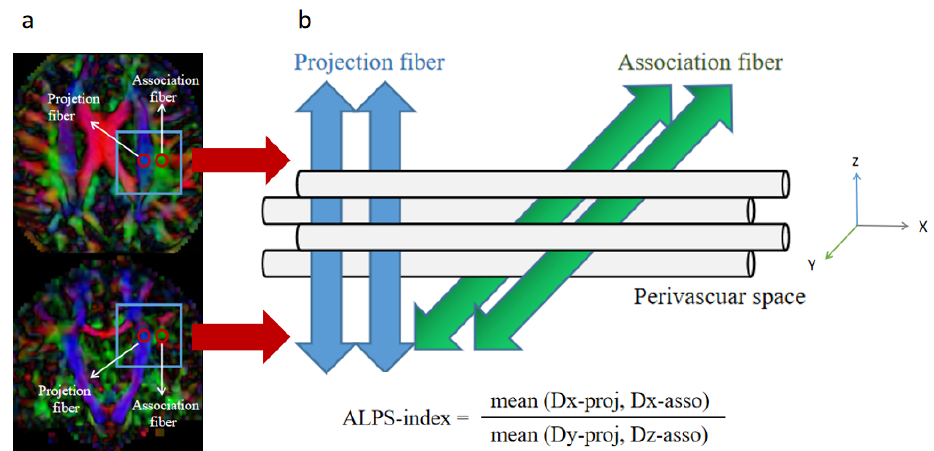
Figure 2. The calculation method used to determine the ALPS-index. ( a ) Two regions of interest were placed on the projection fiber and association fiber using the color FA map. ( b ) Schematic diagram showing the relationship between the orientation of the perivascular space and fibers, and the formula for calculating the ALPS-index. Abbreviation: ALPS-index, the index of Diffusion Tensor Image Analysis along the Perivascular Space.